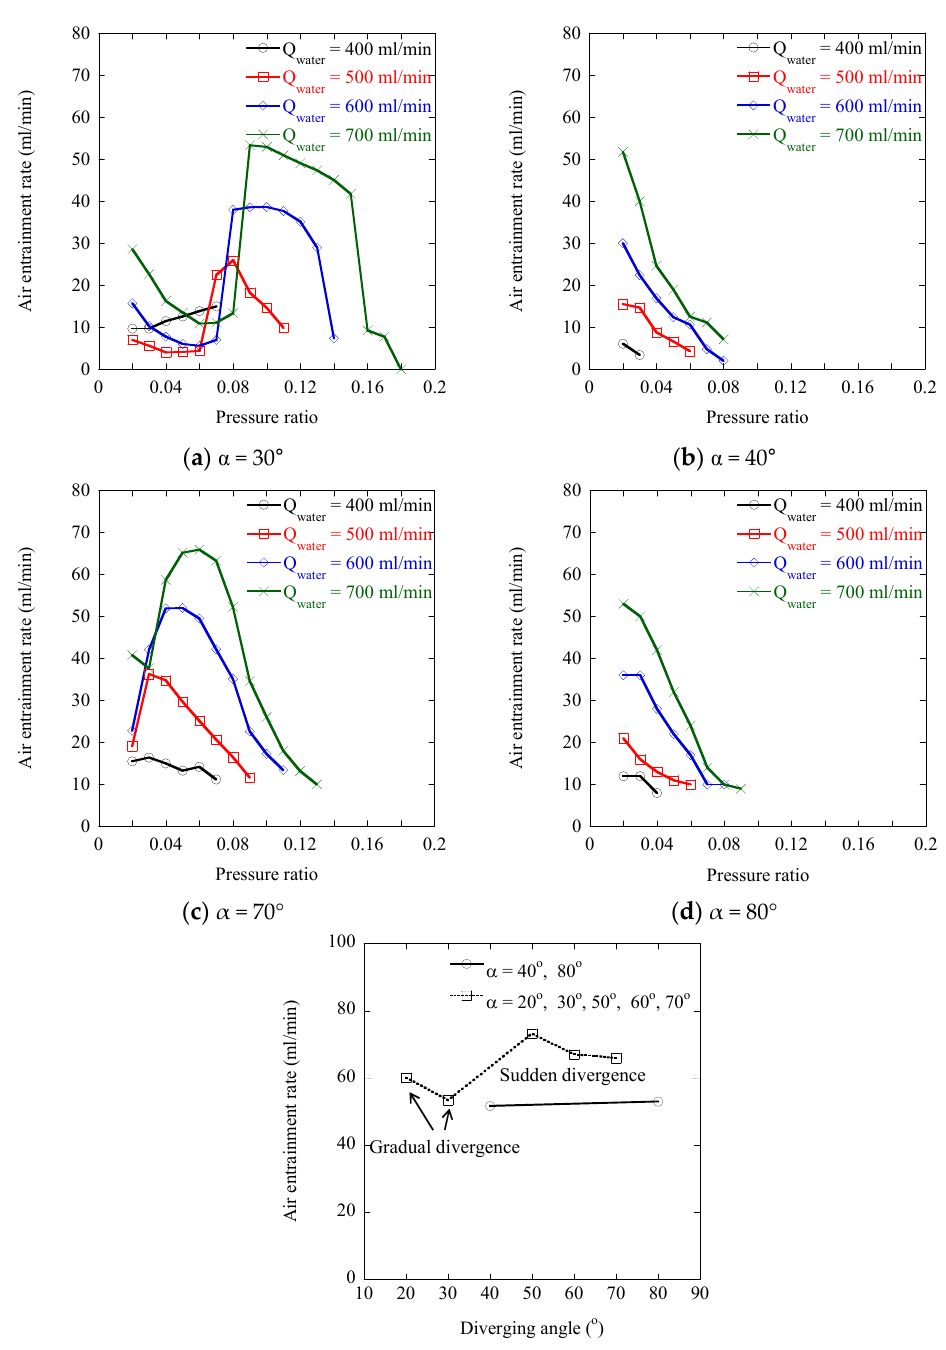
Figure 6. For a various diverging angle, characteristic of air entrainment rate according to the pressure ratio and water flow rate.